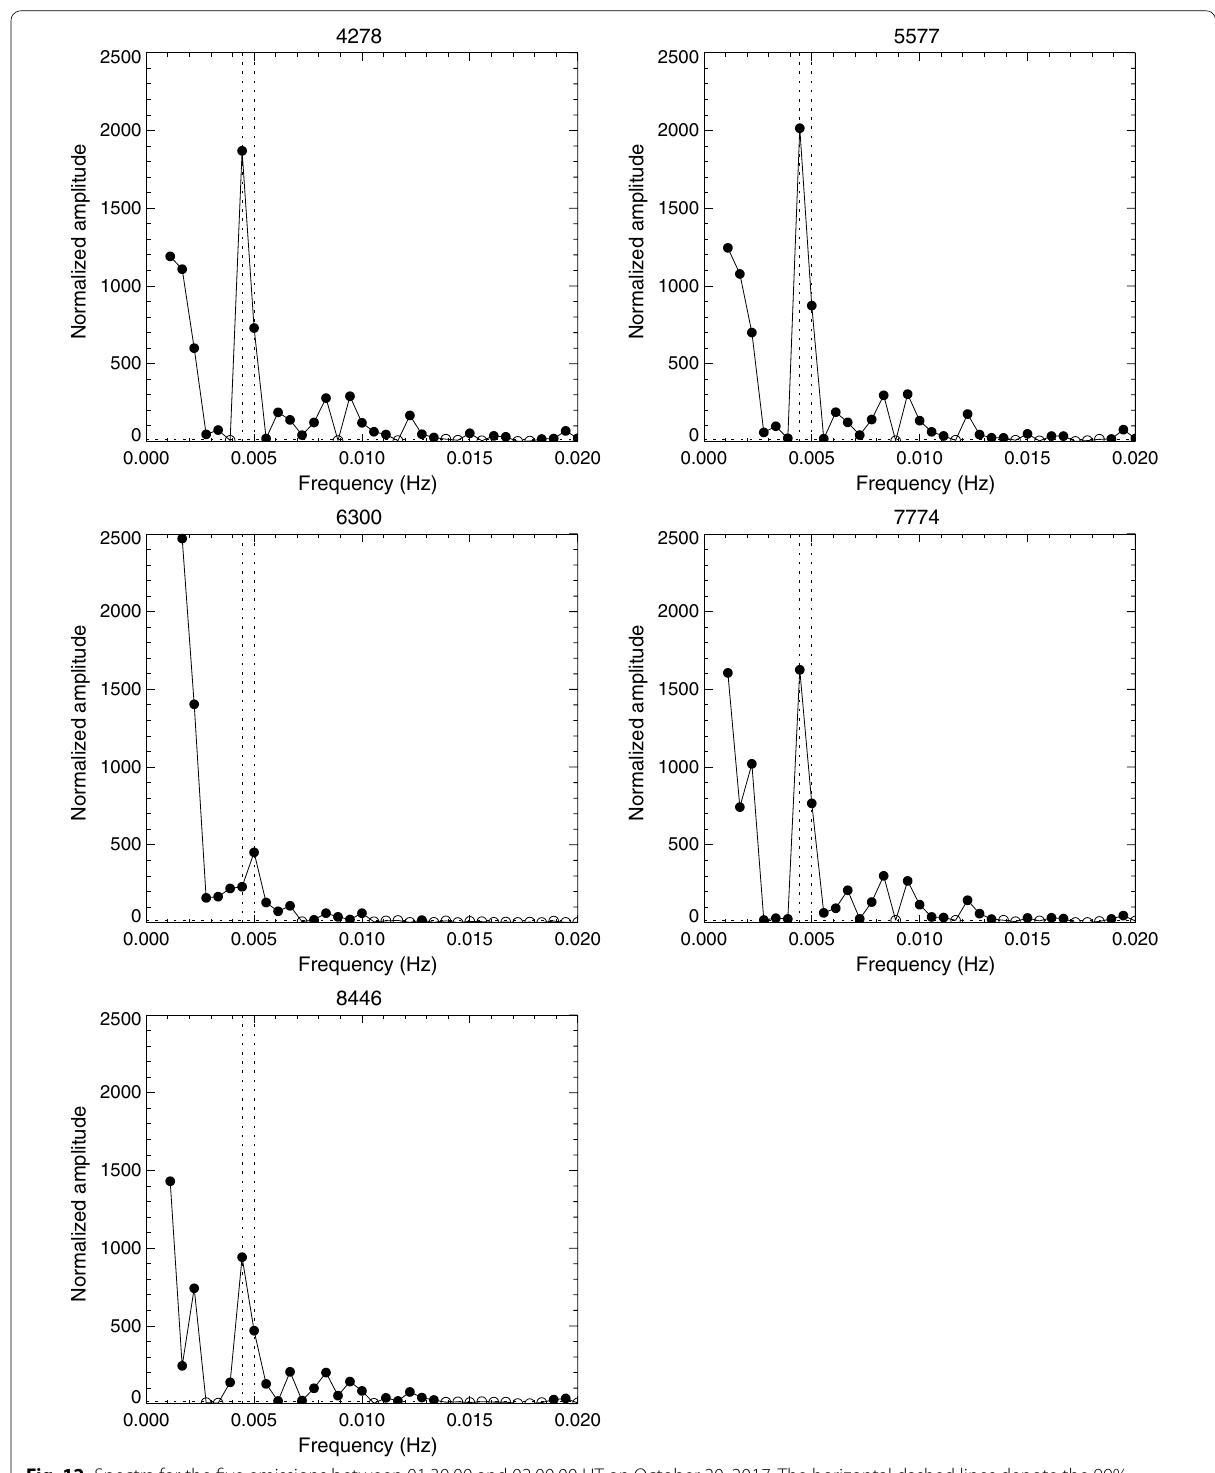
Fig. 12 Spectra for the five emissions between 01:30:00 and 02:00:00 UT on October 20, 2017. The horizontal dashed lines denote the 99% significance level. The vertical dotted lines denote oscillations of 1/200 and 1/225 Hz (i.e., periods being 200 and 225 s, respectively). Closed (open) circles denote data whose values are greater (smaller) than the 99% significance